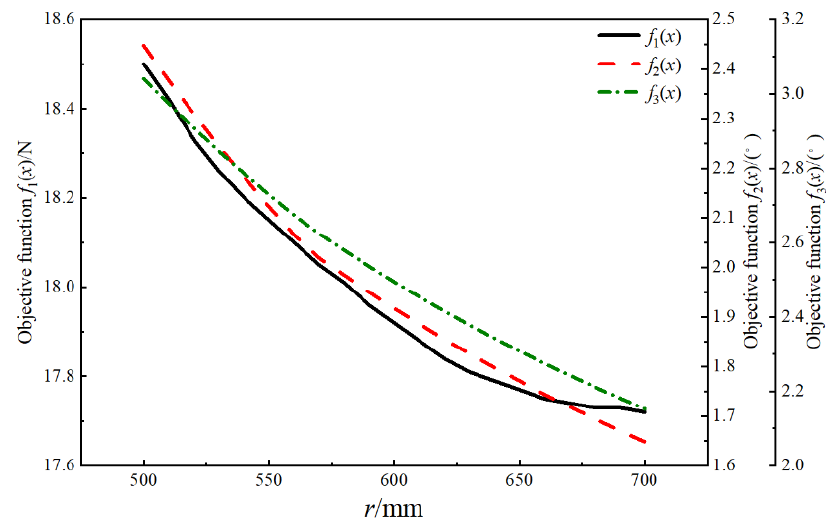
Figure 6. Variation curve of the objective function with the distribution circle radius r of the geometric center of the spherical hinge of the mobile platform.